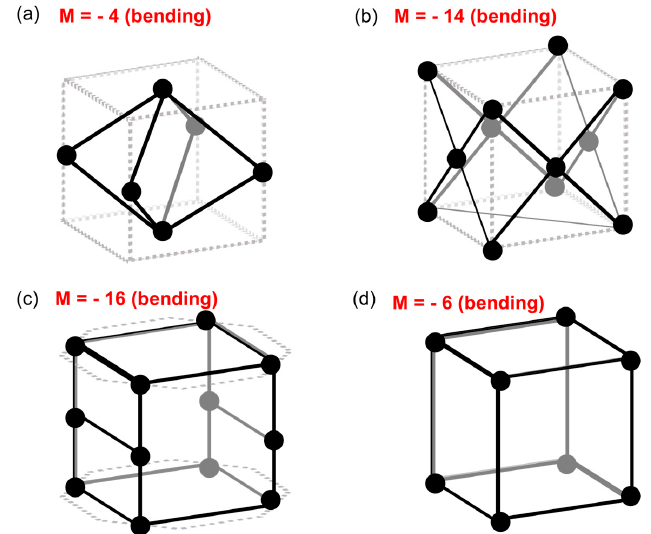
Figure 5. UC CAD models for the topologies: ( a ) BCC; ( b ) FCC; ( c ) AUX; ( d ) ORG. Pin ended truss approximations of these UCs were assessed to confirm that they would exhibit bending dominated deformation, using Maxwell’s stability criterion as shown in Figure 6.